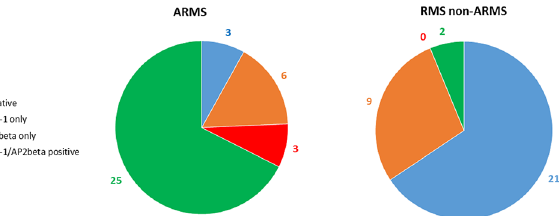
Fig 5. Pie charts showing the amounts of individual and co-expression of DAX-1 and Ap2 β in ARMS t + and non-ARMS. (The arabic numbers indicate the number of positive tumors for each